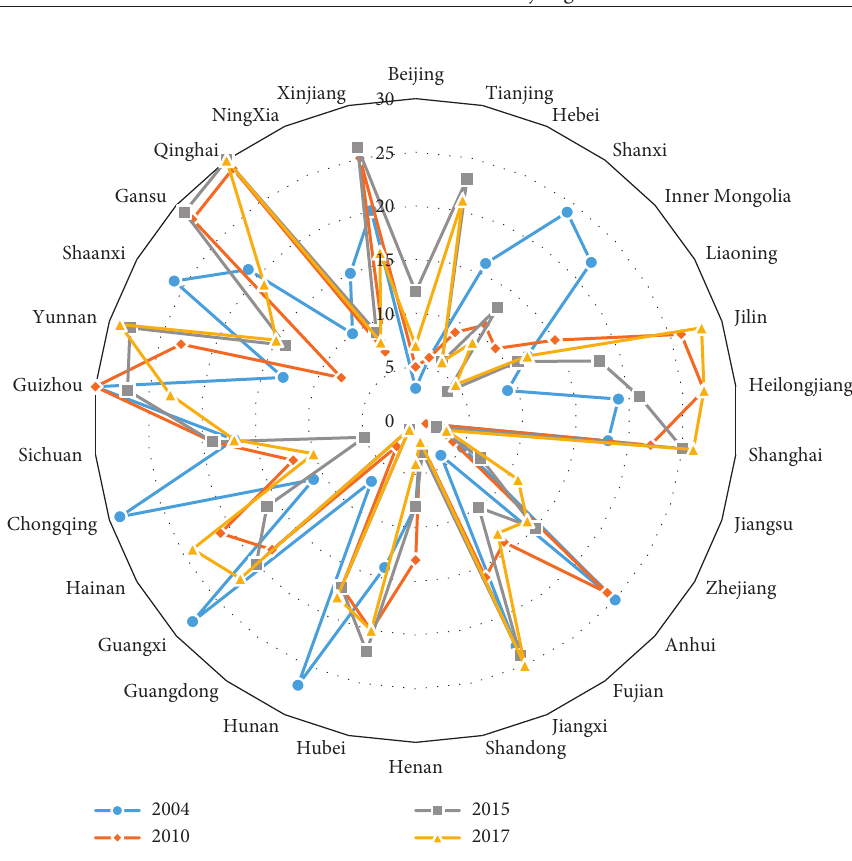
Figure 2: ER subsystem ranking in 2004, 2010, 2015, and